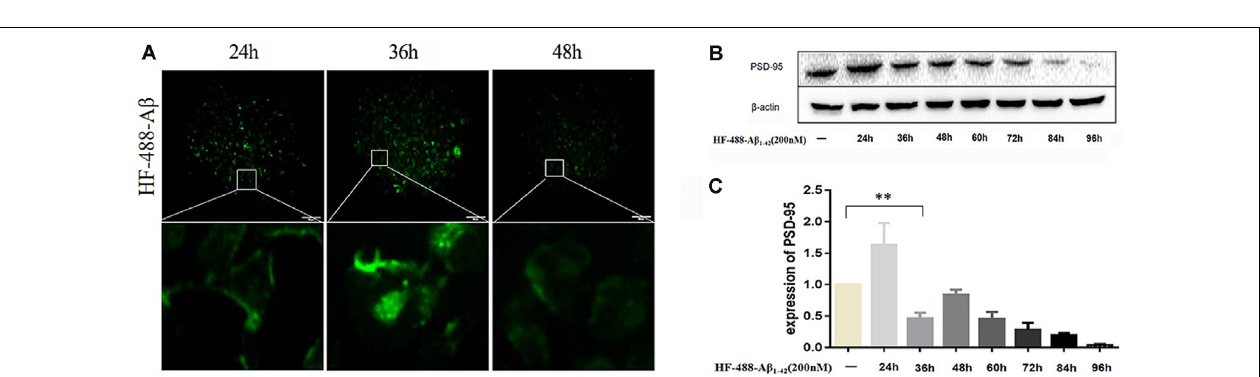
FIGURE 1 | Immunofluorescence staining of the neuronal marker NeuN in differentiated SH-SY5Y cells. Differentiated cells show more protrusions and branches, and they are more neuron-like.